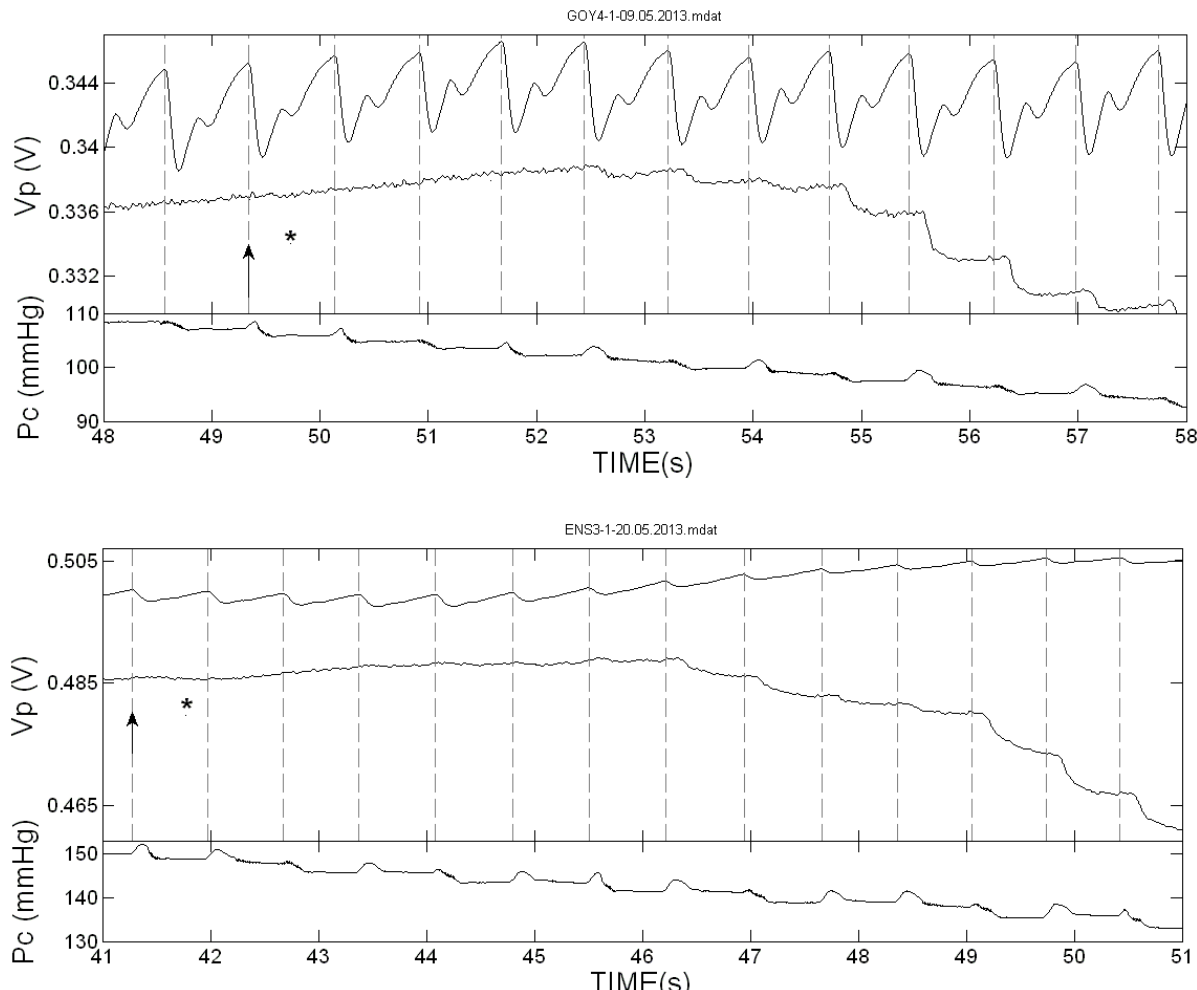
Figure 3. The PPG pulses (V ) in the two hands of two of the subjects during cuff P deflation for cuff pressures in the neighborhood of the SBP value, and the cuff-pressure P